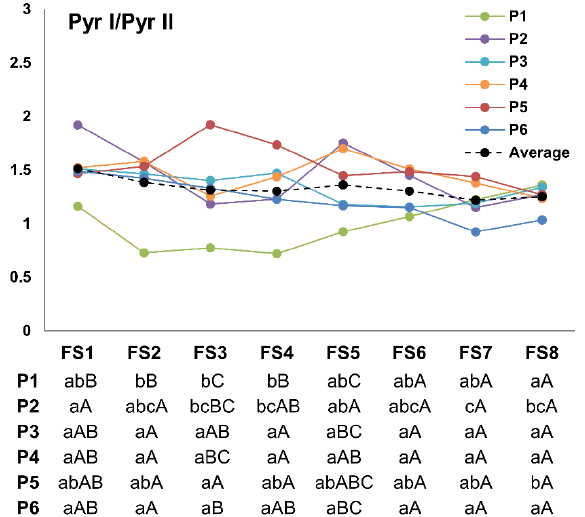
Figure 4. Pyrethrin I to pyrethrin II ratio across the eight flower developmental stages in six Dalmatian pyrethrum populations. Lowercase letters refer to differences between phases in the same population, while uppercase letters refer to differences between populations within the same phase.